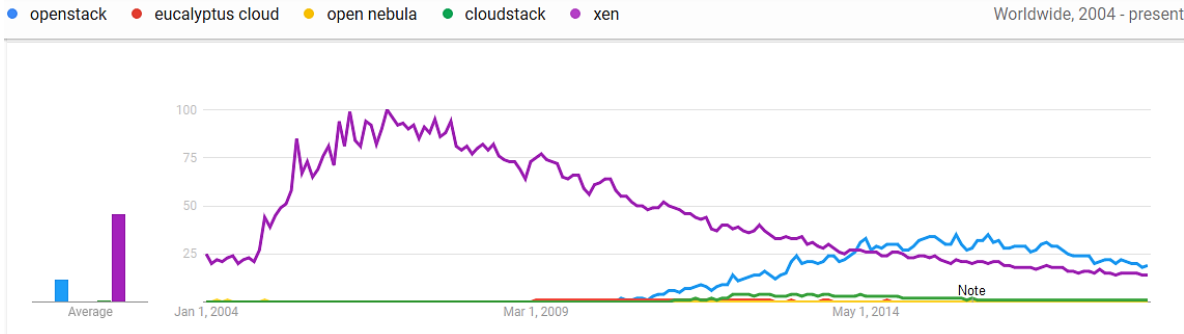
Figure 1. OpenStack, Eucalyptus, OpenNebula, CloudStack and Xen from Google Trends.